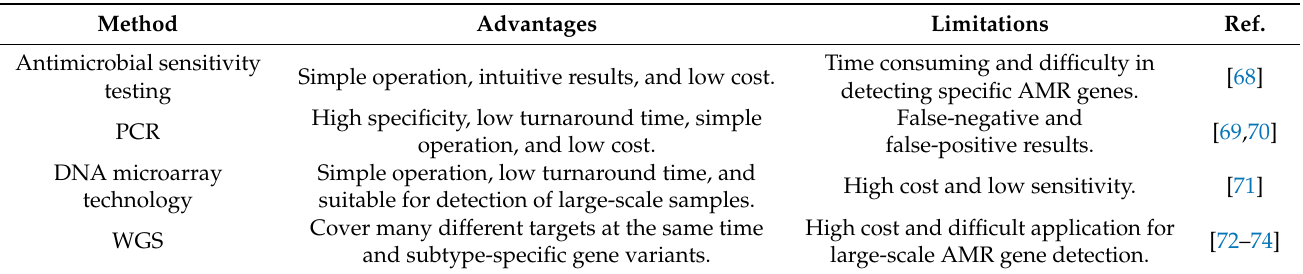
Table 3. Comparison of methods for detection of AMR